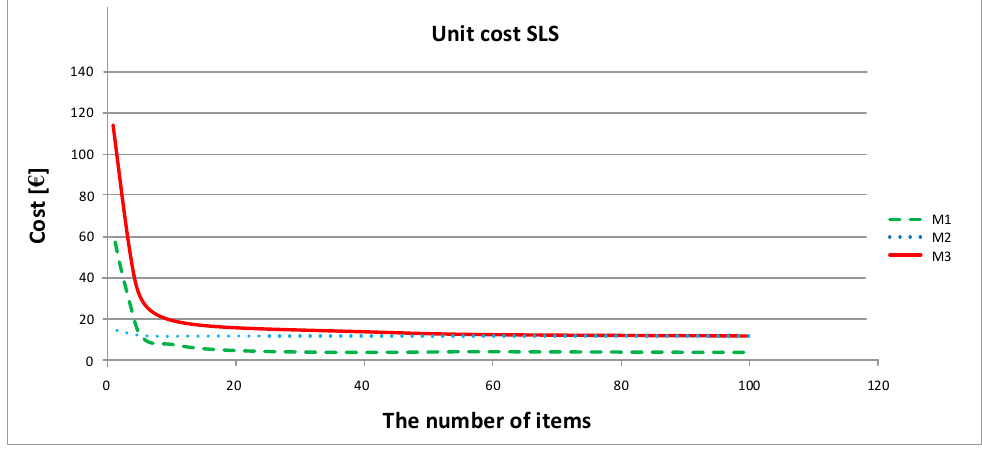
Figure 13. Dependence of the costs of bracket production on the number of prototypes for FDM technology.